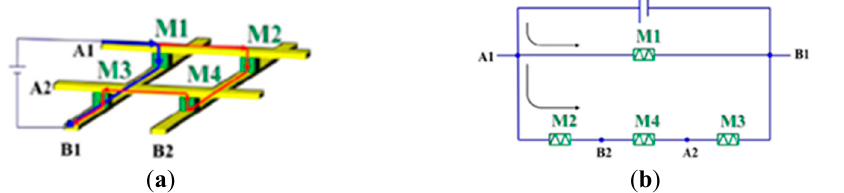
Figure 16. Memristors structure and equivalent circuit ( a ) A memristor crossbar array. ( b ) The sneak path problem in circuit.